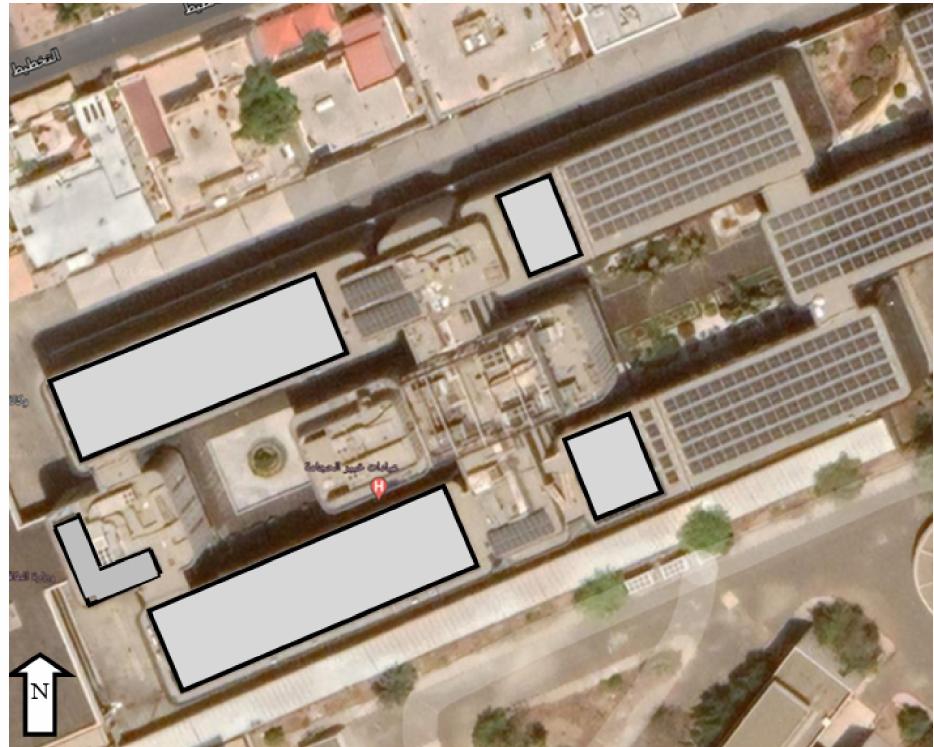
Figure 5. Distribution of the panels in the second scenario.